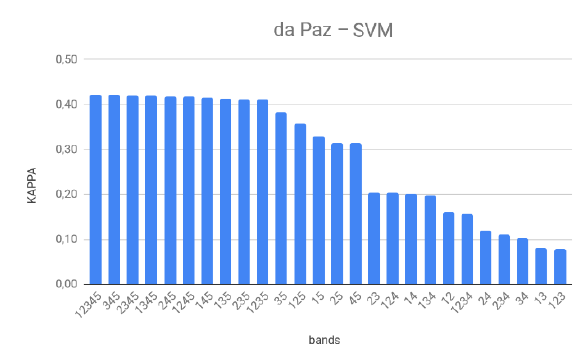
Figure 5 . Variation of the cover index due to the combination of bands in da Paz . Although combination of bands with the best performance for da Paz landscape was B12345, in general, the lower correlation between the layers of information, the better performance of SVM method.